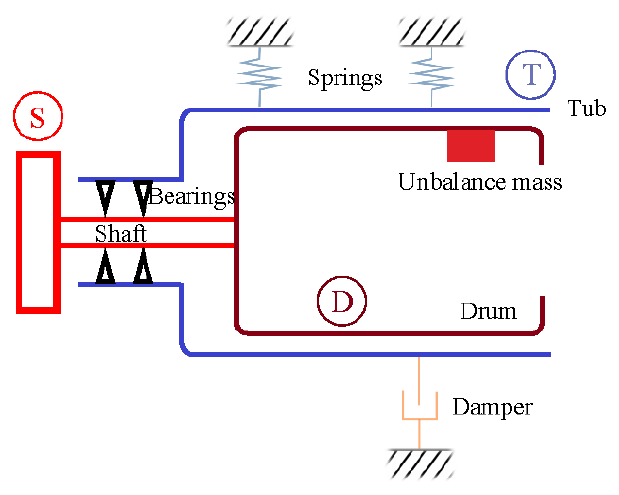
Figure 1. The schematic of a simplified front-loading type washing machine model.